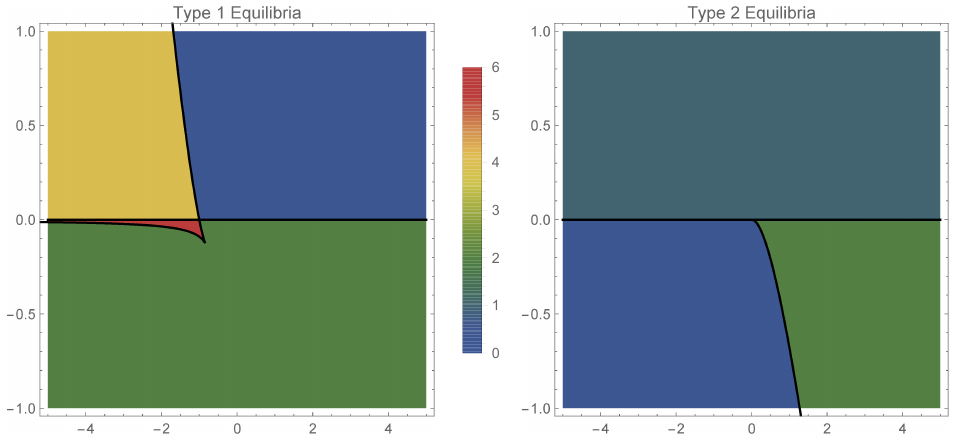
Figure 1. Number of equilibria in the two cases: case 1 ( left ) and case 2 ( right ), depending on κ (horizontal axis) and η (vertical